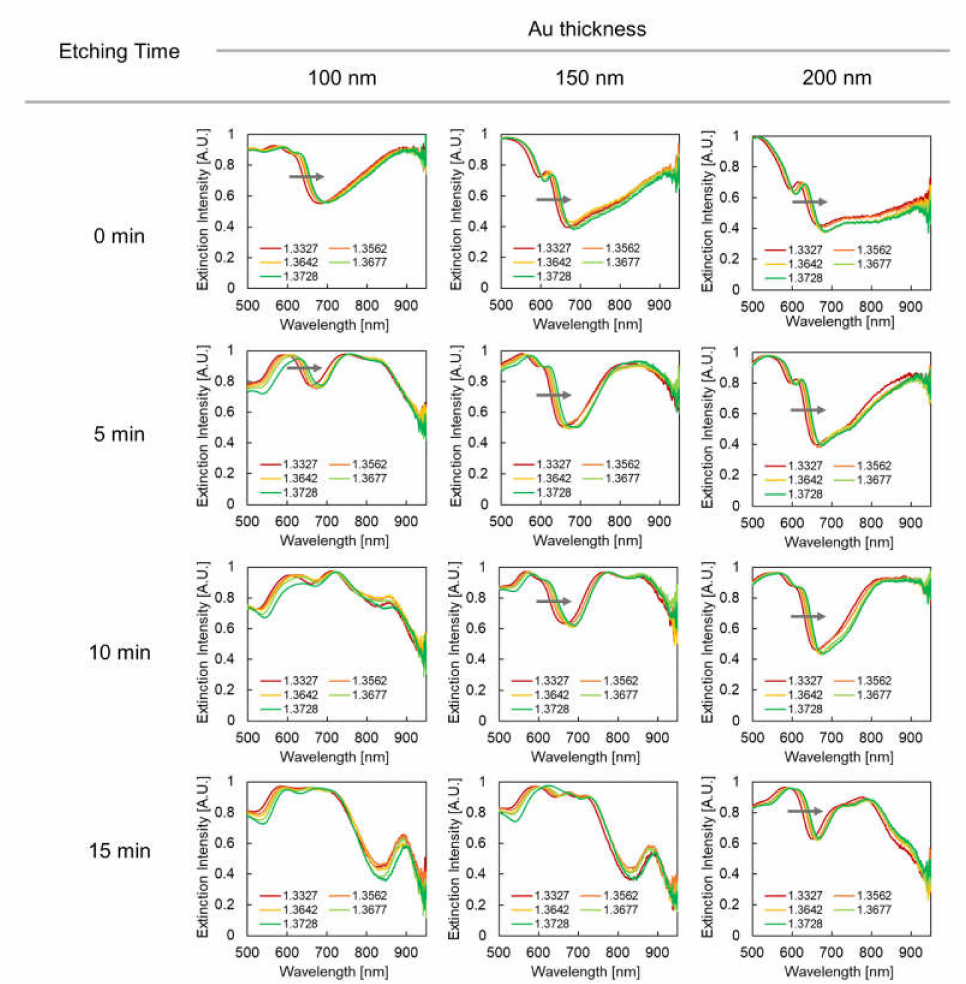
Figure 9. Extinction spectra of plasmonic devices based on surrounding refractive index. Columns indicate Au thickness, rows indicate etching time, and the chart series in the graphs indicates surrounding refractive index. The gray arrows indicate the spectral shift (inflection point shift) evaluated in this study.